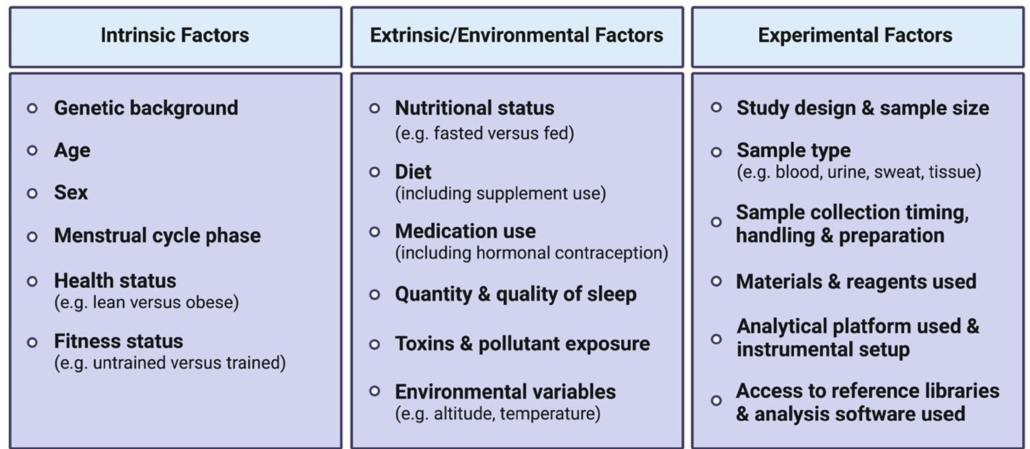
Figure 4. Summary of some of the main factors responsible for variance between metabolomics/lipidomics studies, including intrinsic, extrinsic/environmental factors and experimental